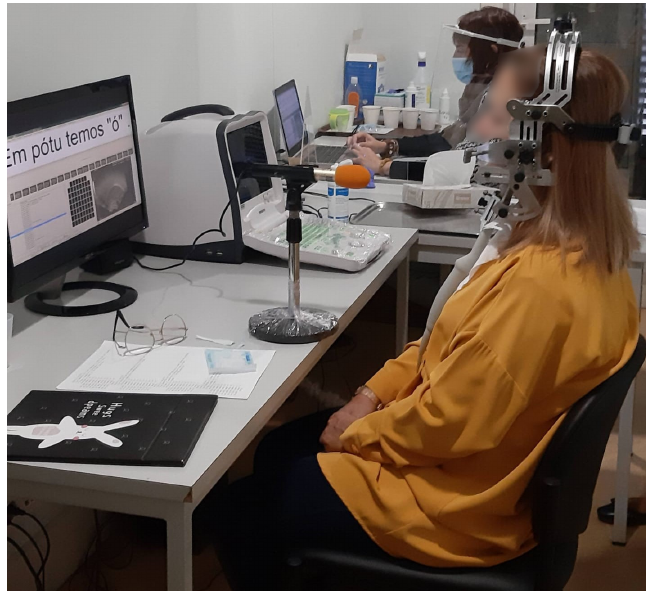
Figure 1. Experimental setup for recording ultrasound: the participant is seated in front of a mi- crophone, wearing a stabilization helmet to keep the ultrasound probe positioned below the chin throughout the experiment. The prompts are presented on a computer